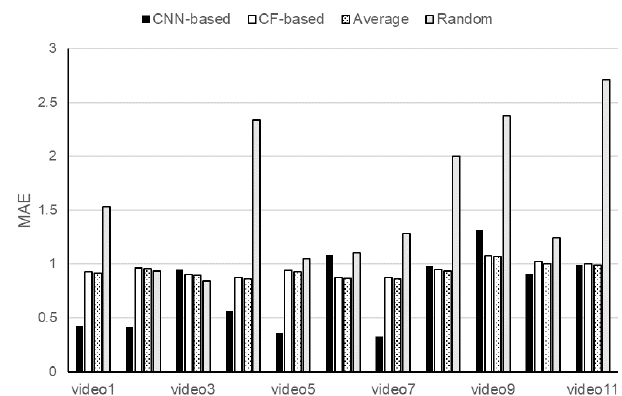
Figure 9. Comparison of rating prediction models for existing users.